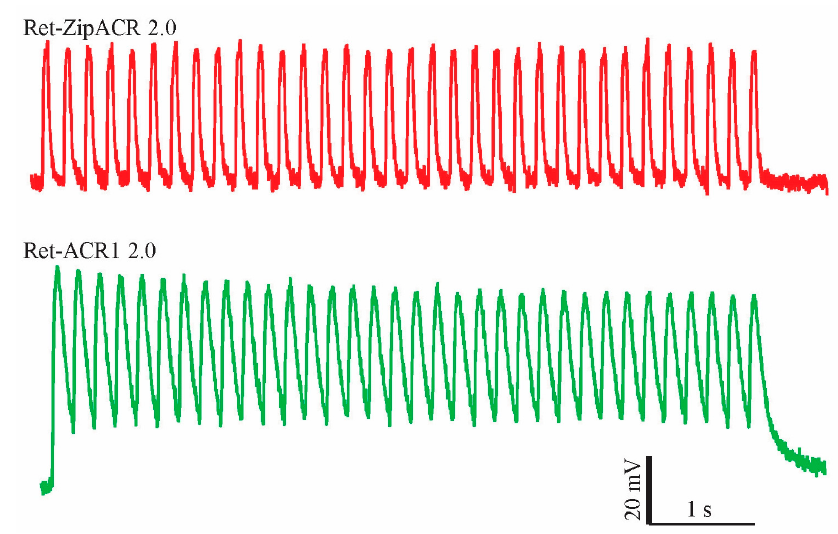
Figure 4. Light-induced depolarizations in tobacco pollen tubes transiently expressing Ret-ZipACR 2.0 (red line) or Ret- ACR1 2.0 (green line). The pollen tubes were illuminated by 50 ms light flashes of 3.5 mW/mm 2 green light (532 nm) at 5 Hz, the downward deflections of the voltage traces correspond to the darkness-regime (150 ms).